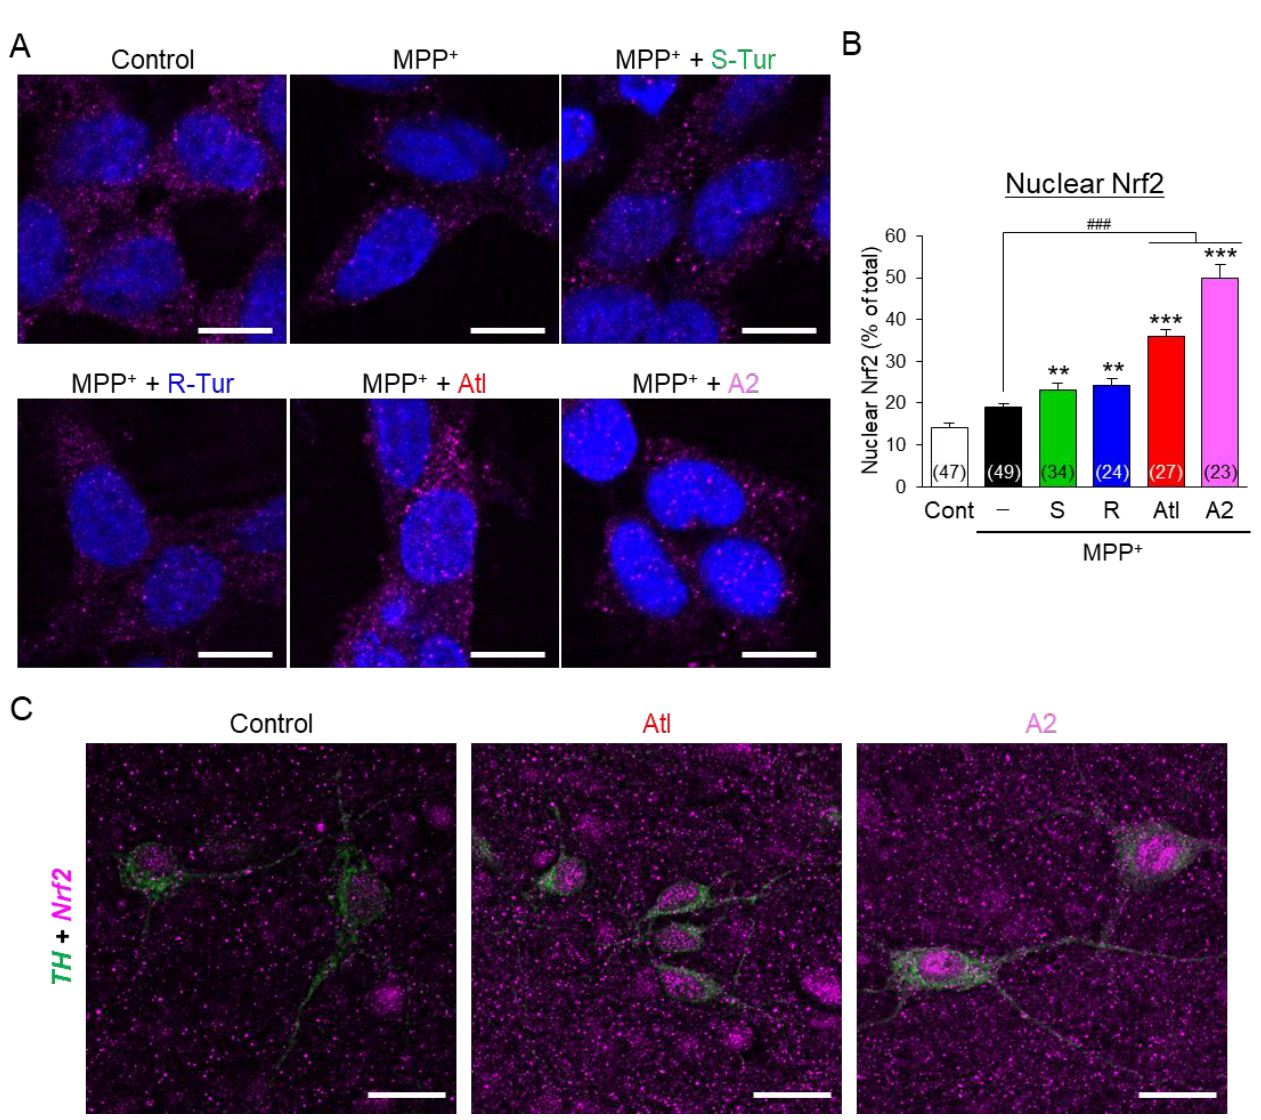
Figure 7. Effects of ar-turmerone analogs on the nuclear expression of Nrf2. ( A ) Representative images of Nrf2 immuno- reactivity (magenta) and nuclear staining with DAPI (blue) in LUHMES cells under control conditions, treated with MPP + (10 μM), and cotreated with MPP + and ar-turmerone analogs (20 μM). Scale bars, 10 μm. ( B ) Quantitative analysis of nuclear localization of Nrf2. The percentage of the nuclear Nrf2 in the total Nrf2 represents nuclear localization of Nrf2. Data are presented as mean ± SEM of 23 − 49 independent cells. Numbers in parentheses indicate biological replicates of each group. ** p < 0.01, *** p < 0.001 vs. control, ### p < 0.001 (n = 23 − 49, Dunn’s multiple comparisons test). ( C ) Representa- tive images of TH (green) and Nrf2 (magenta) immunoreactivity in midbrain slice cultures under control conditions and treated with Atl or A2 (20 μM). Scale bars, 20 μm.